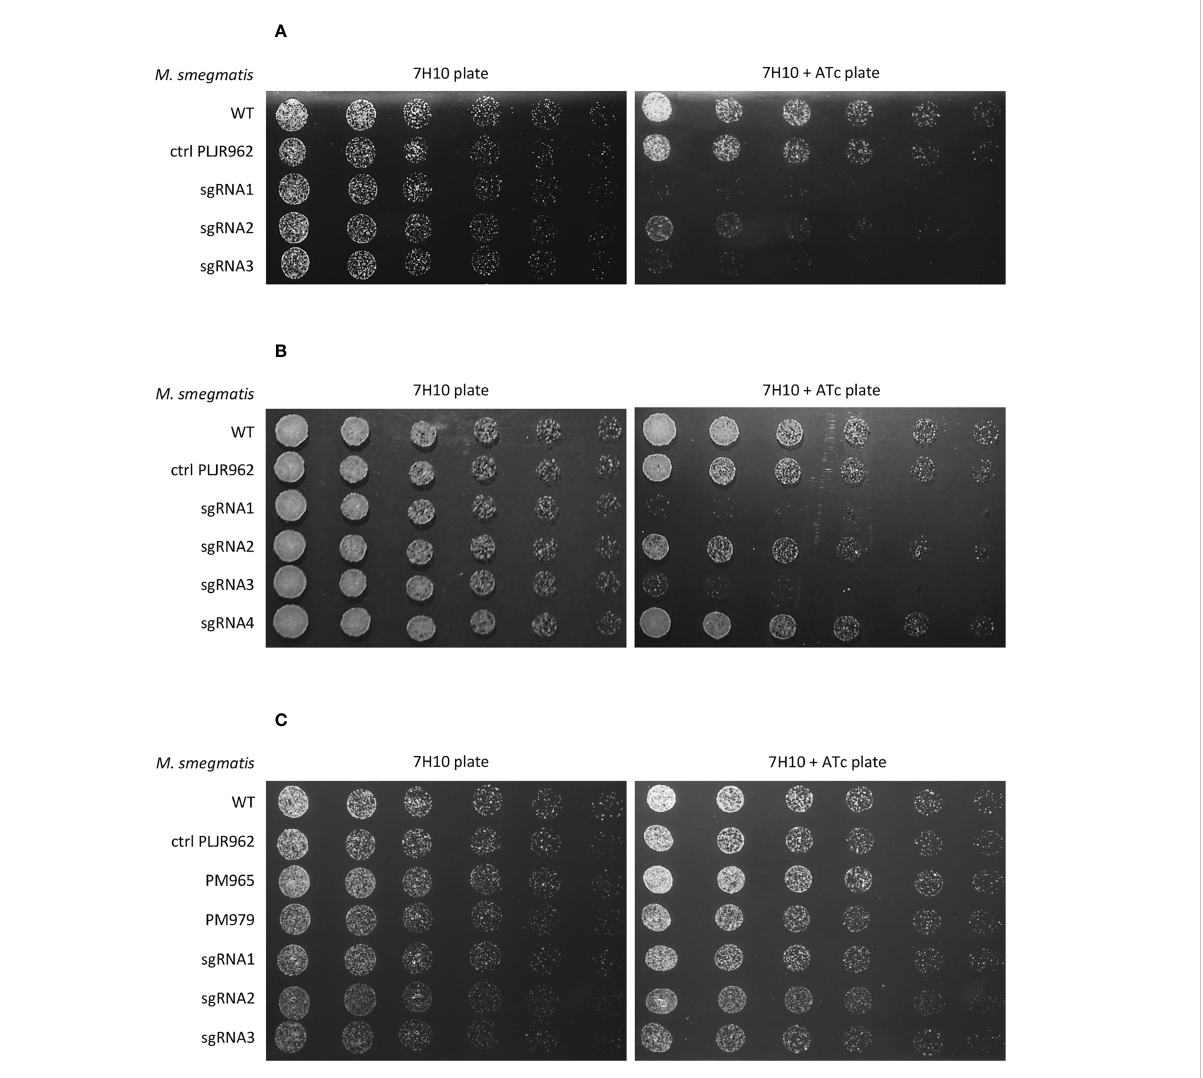
FIGURE 2 Spotting assays of all M. smegmatis knockdown mutants (n=3): (A) murT knockdown mutants; (B) gatD knockdown mutants; (C) namH knockdown mutants. Negative controls ( M. smegmatis WT, PLJR962 and PM965) and a positive control ( M. smegmatis PM979) were included in all experiments. The fi rst spots were normalized to an OD 600 of 0.001 and the next were performed by preparing and spotting 2-fold serial dilutions of each culture on agar